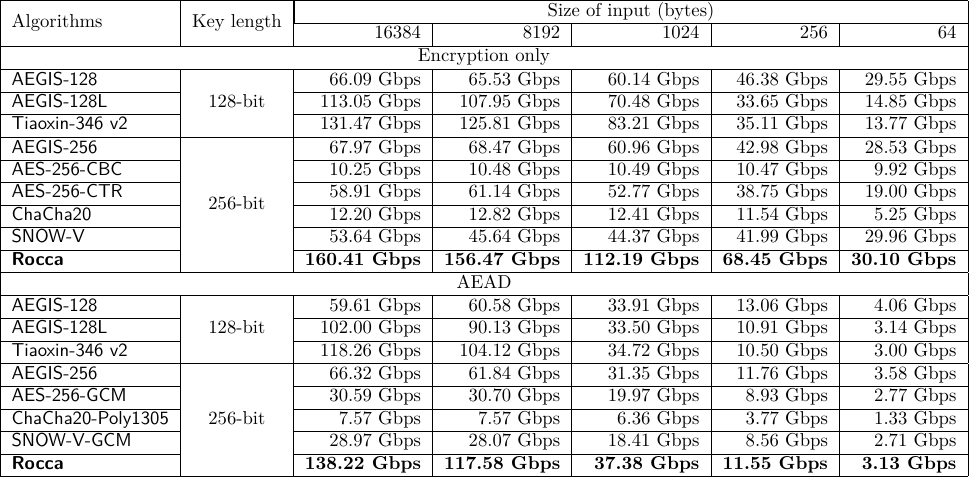
Table 7: Performance